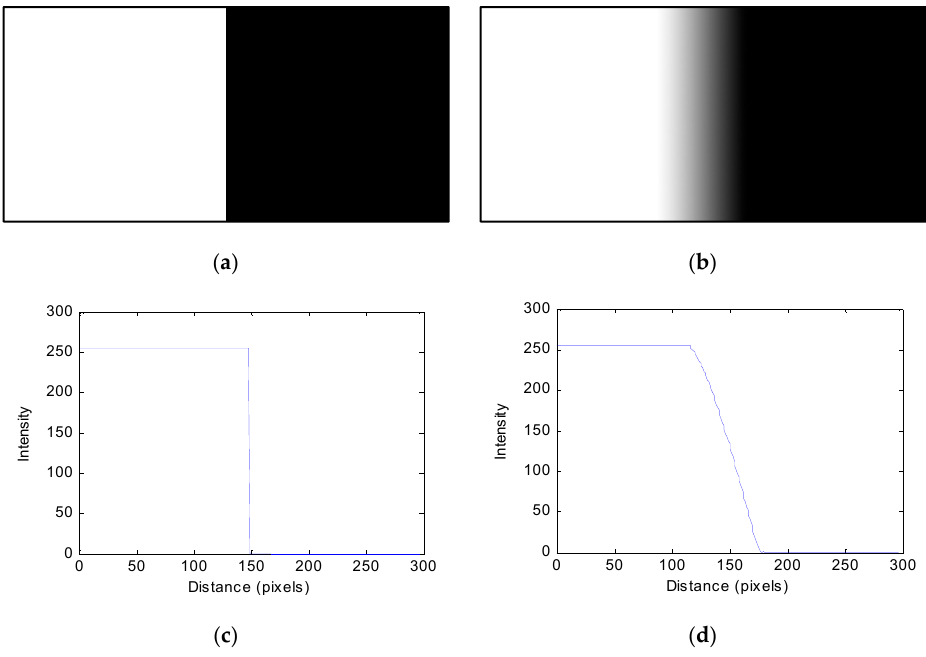
Figure 1. Edge analysis in the crack image: ( a ) object, ( b ) image, ( c ) ESF of object, ( d ) ESF of image.